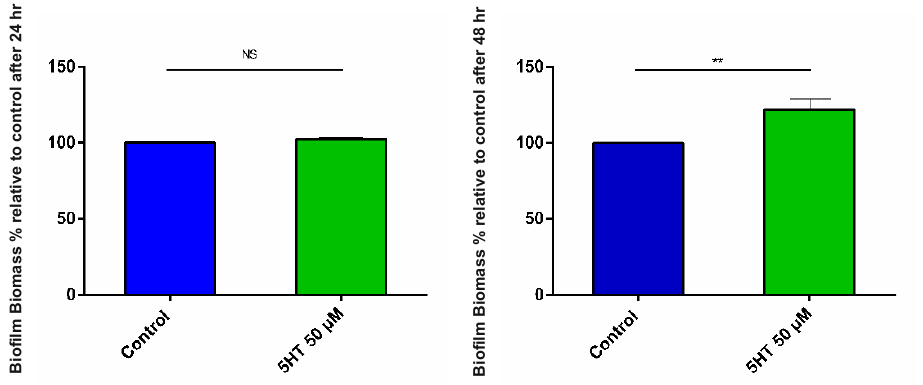
Figure 4. Biofilm. Biofilm biomass formation revealed with the crystal violet staining method, after the treatment of E. faecium NCIMB10415 with 50 µM 5HT for 24 h or 48 h, and expressed in % of control. The stimulating effect of 5HT is detectable only after 48 h of growth (NS: not significant, ** p < 0.01).